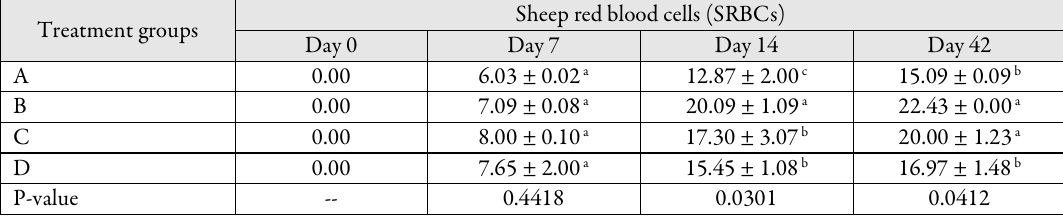
Values presented in mean ± standard error of the